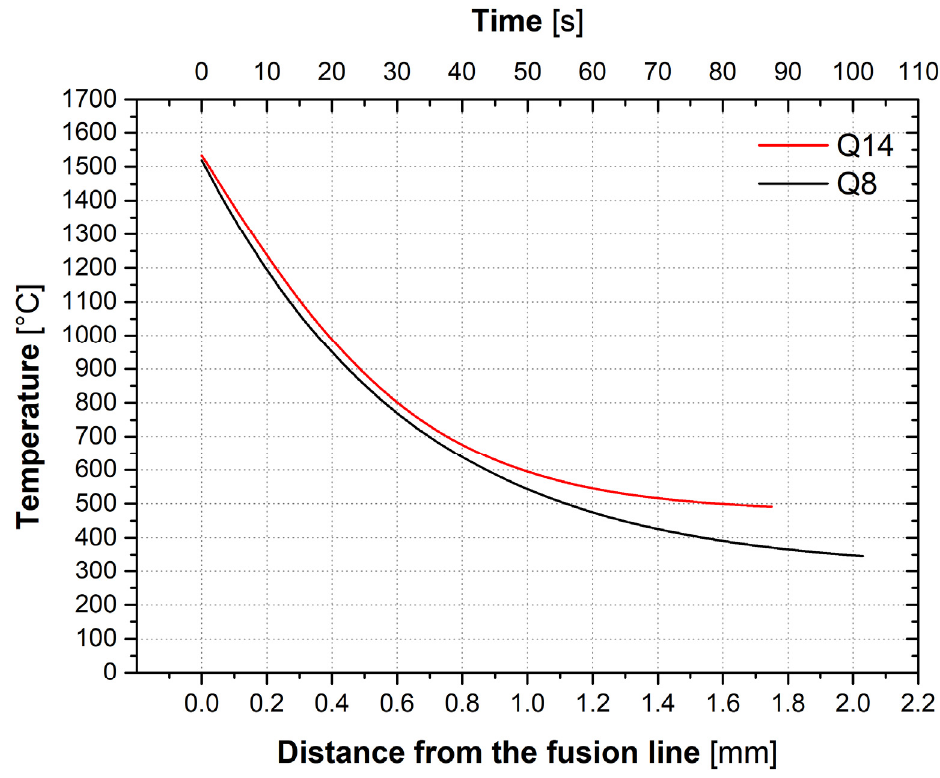
Figure 16. Comparison of the maximum temperatures distribution in HAZ as a function of the heat input value.